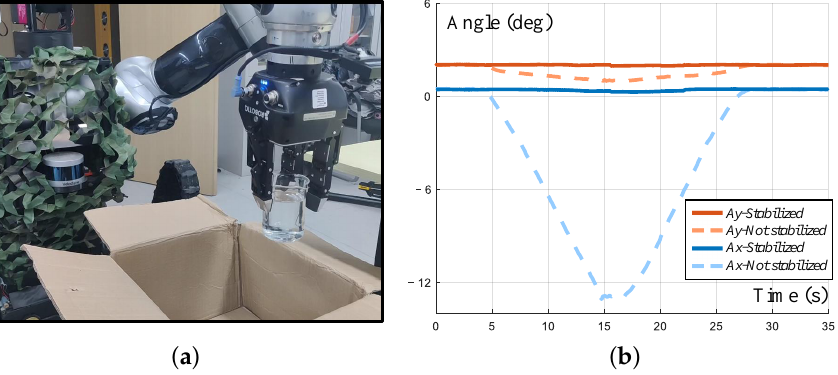
Figure 14. End-effector stabilization experiment. ( a ) Experiment setup. An IMU is mounted on left arm end; ( b ) Experiment result. The fluctuation of the end attitude is slight when the end is